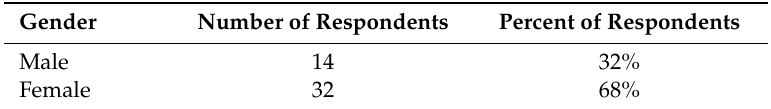
Table A4. Gender of participants.